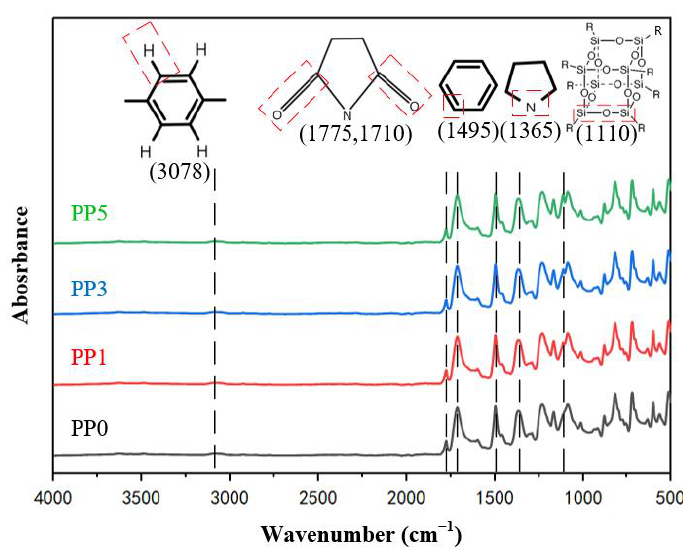
Figure 4. Infrared absorption spectrum of